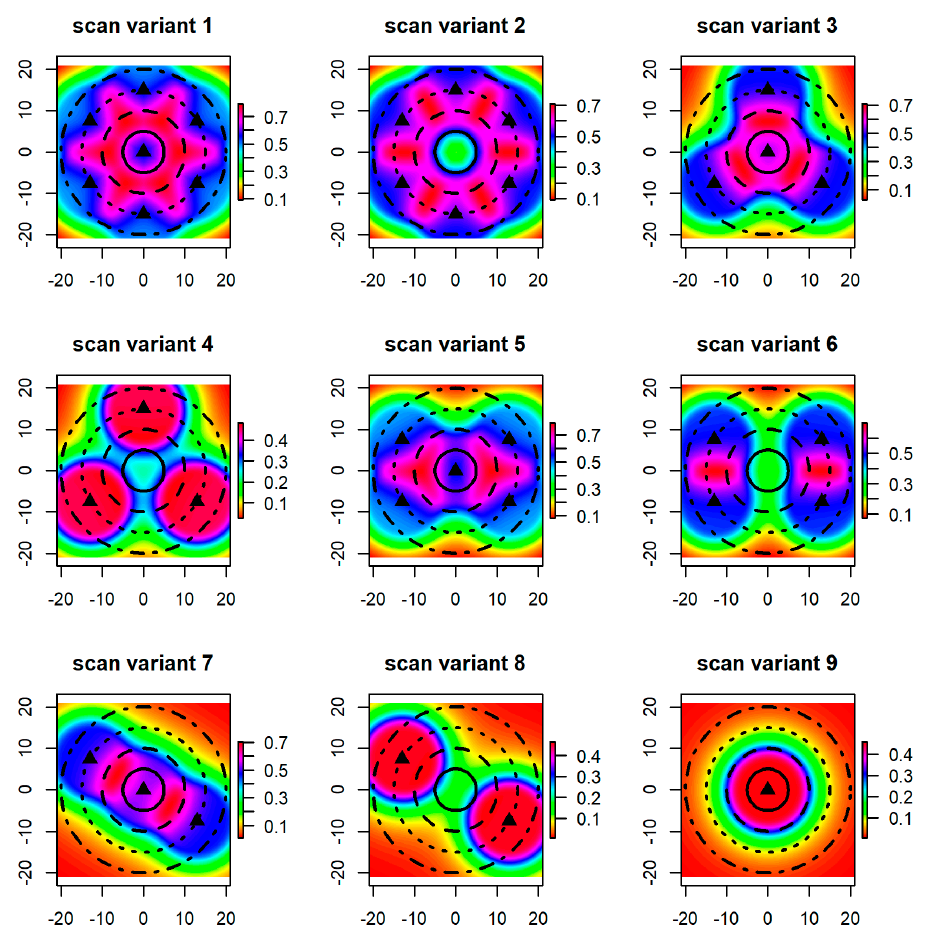
Figure A1. Distance-dependent detection probabilities P of small trees (5 cm ≤ dbh < 20 cm) for all scan variants described by Gollob et al. [43]. Black triangles indicate the scanner positions; the different dashed lines indicate circular sample plots with 5, 10, 15, and 20 m radii, respectively. Axis labels are the local x- and y-coordinates (m). Cell size of the raster is 1 cm × 1 cm.